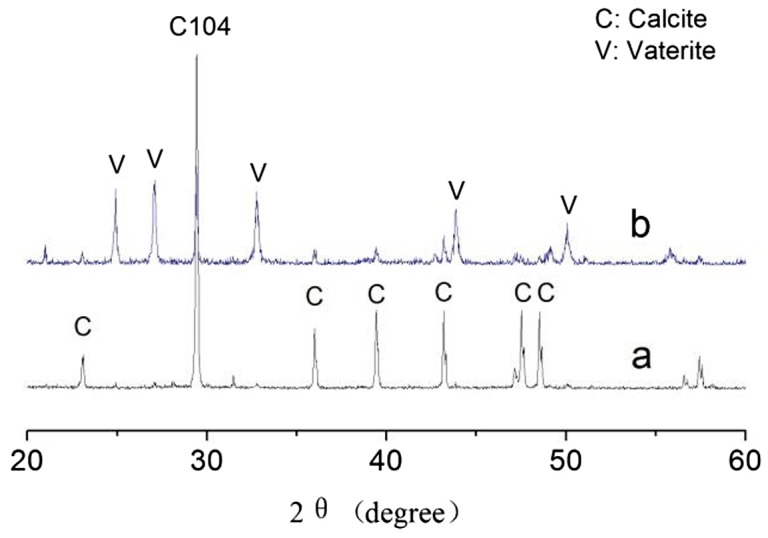
XRD image of the CaCO3 crystal formed in the absence of MA/APEG-PG-(OH)5 copolymer (a) and with the presence of 6 mg/L MA/APEG-PG-(OH)5 copolymer (b).